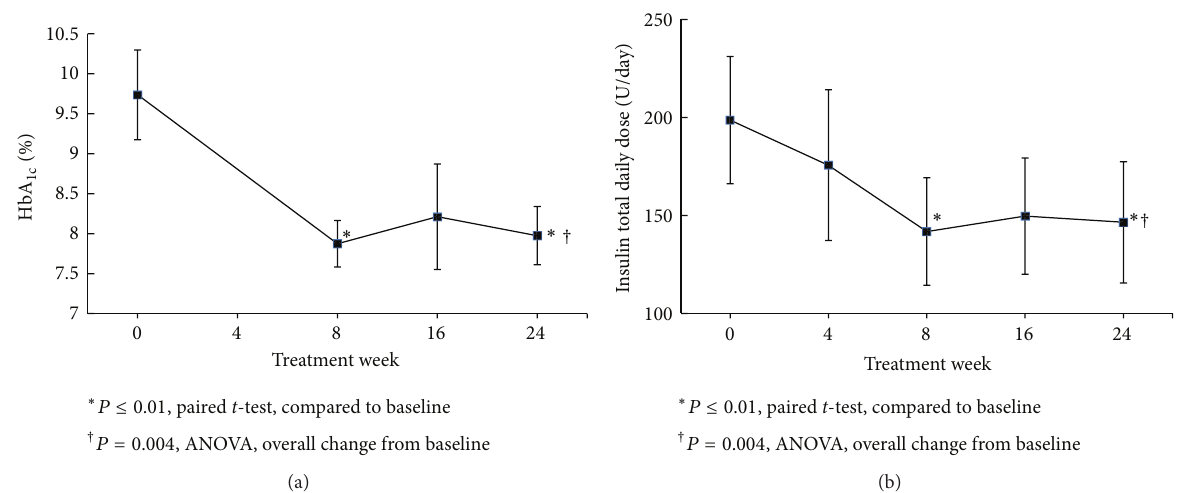
Figure 1: Effect of bromocriptine-QR therapy on HbA 1 on metformin plus high-dose basal-bolus insulin therapy at baseline.